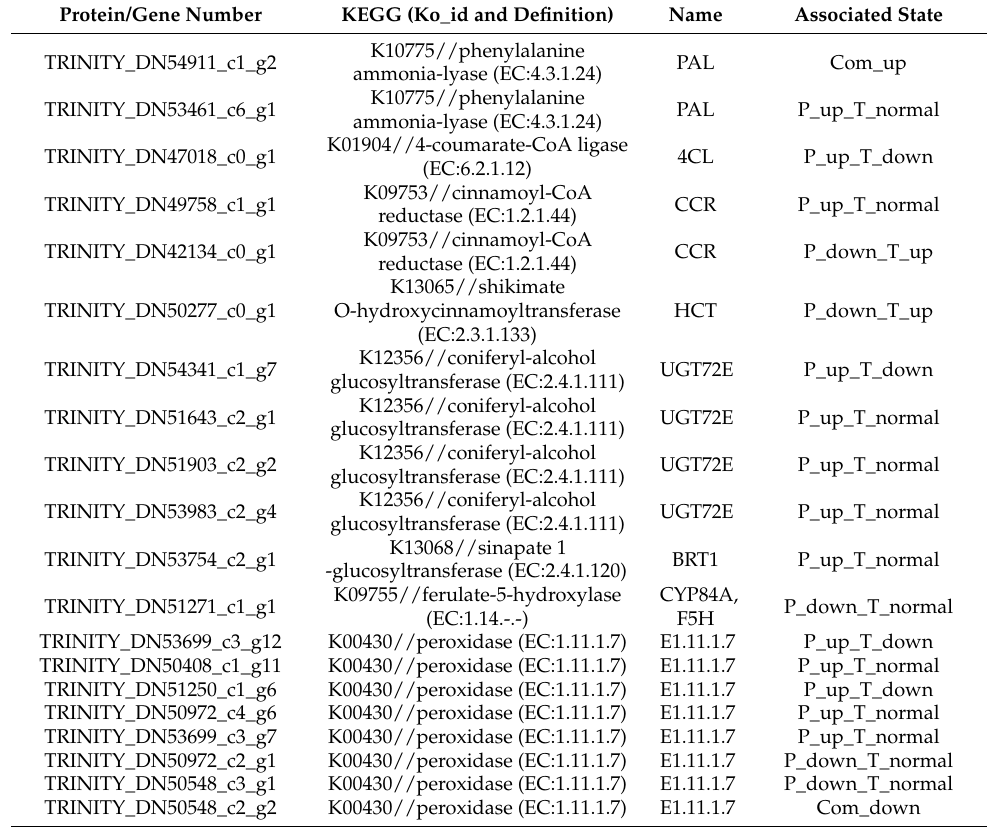
Table 4. Differential expression proteins and their corresponding genes in phenylpropane